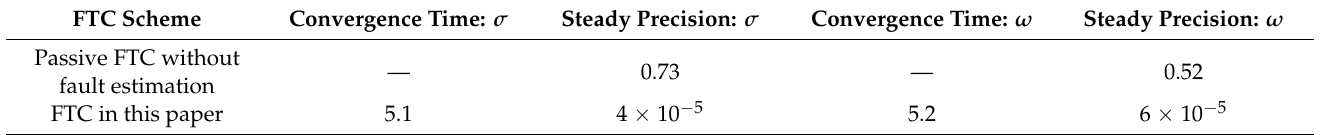
Table 3. Comparative analysis of performance with proposed FTC without fault estimation. Table 5. Comparative analysis of performance with proposed FTC without anti-saturation method.